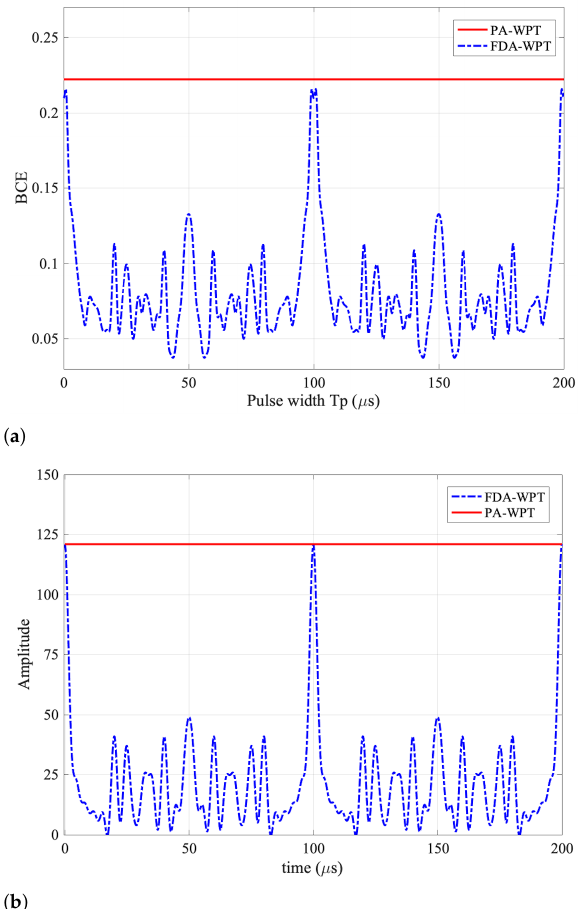
Figure 6. Performance comparison between the FDA-WPT and the PA-WPT. ( a ) BCE curve versus pulse width T p at the target area Ψ is Ψ { ( θ , π ) | θ ∈ [ 0, π ] , ϕ ∈ [ − 20 ◦ ,20 ◦ ] } , ( b ) the signal amplitude versus time curve at target point (0 ◦ ,0 ◦